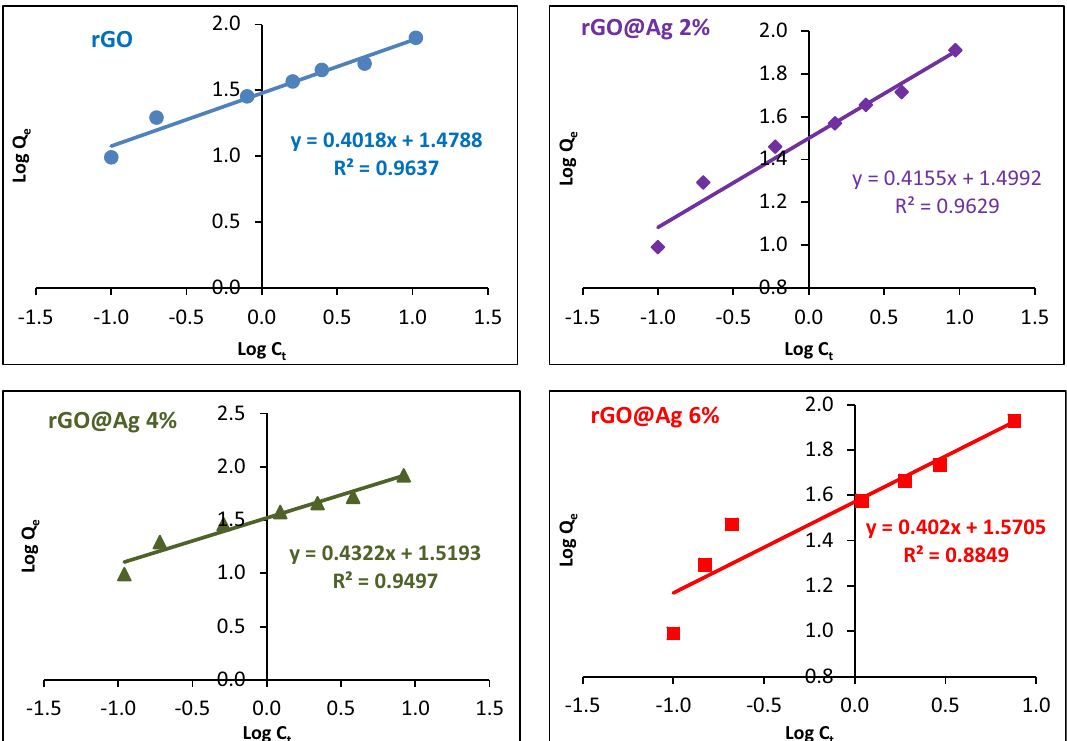
Fig. 13 Graph of Freundlich isotherm model for CR degradation using as-synthesized rGO and rGO@Ag x % nanocomposites